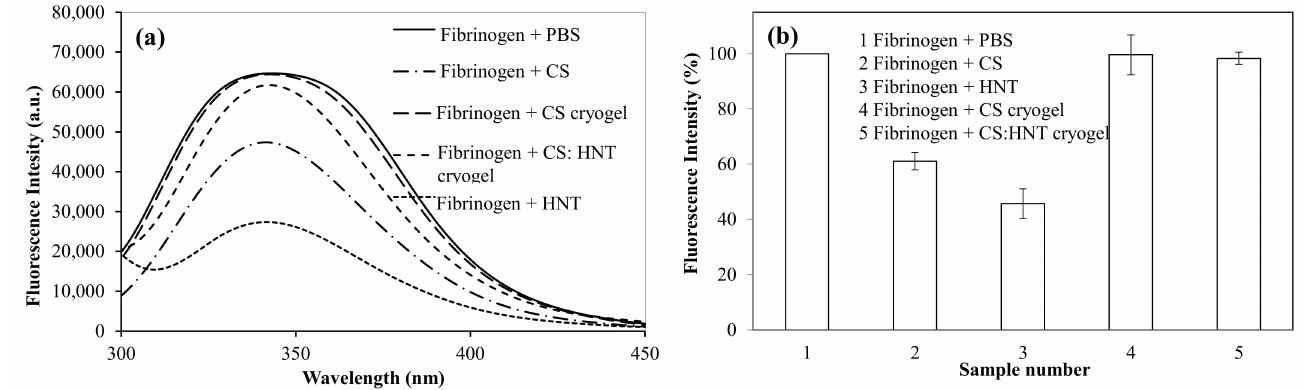
Figure 6. ( a ) The reduction in the fluorescent intensity of fibrinogen upon interaction with CS, HNT, CS cryogel and CS:HNT cryogel at the concentration of 1.0 mg/mL, and ( b ) the percentage change in emission intensity of CS, HNT, CS cryogel and CS:HNT cryogel interacting with fibrinogen at 341 nm wavelength (excitation wavelength: 280